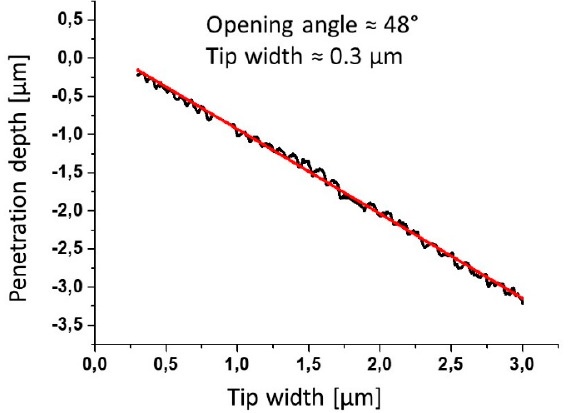
Figure 14. Measured sink-in depth of the tip versus groove width (see Figure 13) of the tip-testing standard. The cone angle of the tip is determined as the arctan of the slope of the linear data fit.